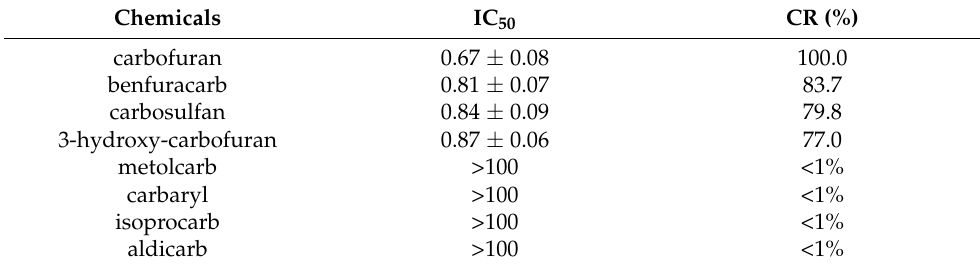
Table 5. Cross-reactivity of QD-LFIA between carbofuran and carbofuran analogues.